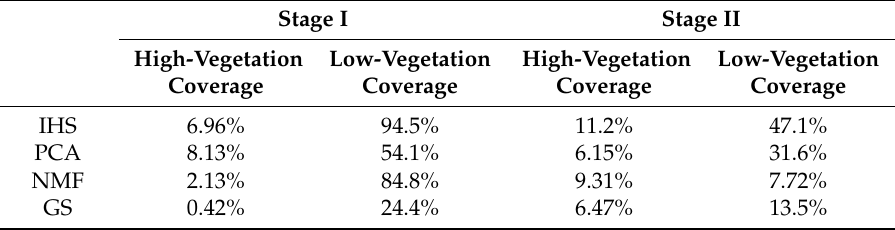
Table 12. Percent improvement in entropy.